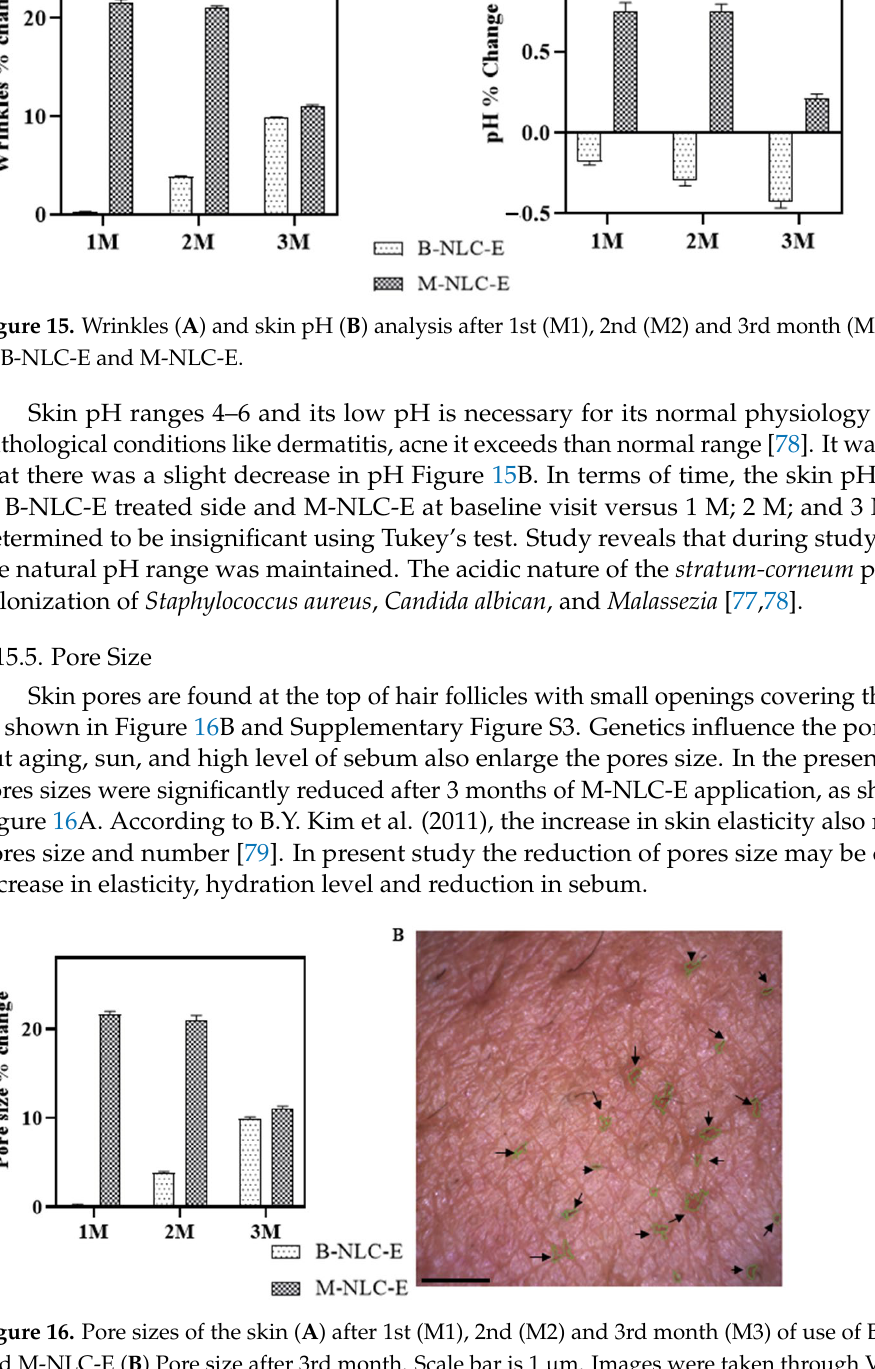
Figure 16. Pore sizes of the skin ( A ) after 1st (M1), 2nd (M2) and 3rd month (M3) of use of B-NLC- E and M-NLC-E ( B ) Pore size after 3rd month. Scale bar is 1 µ m. Images were taken through Vi- sioscan attached with CSI. Data shown as means ± SD.